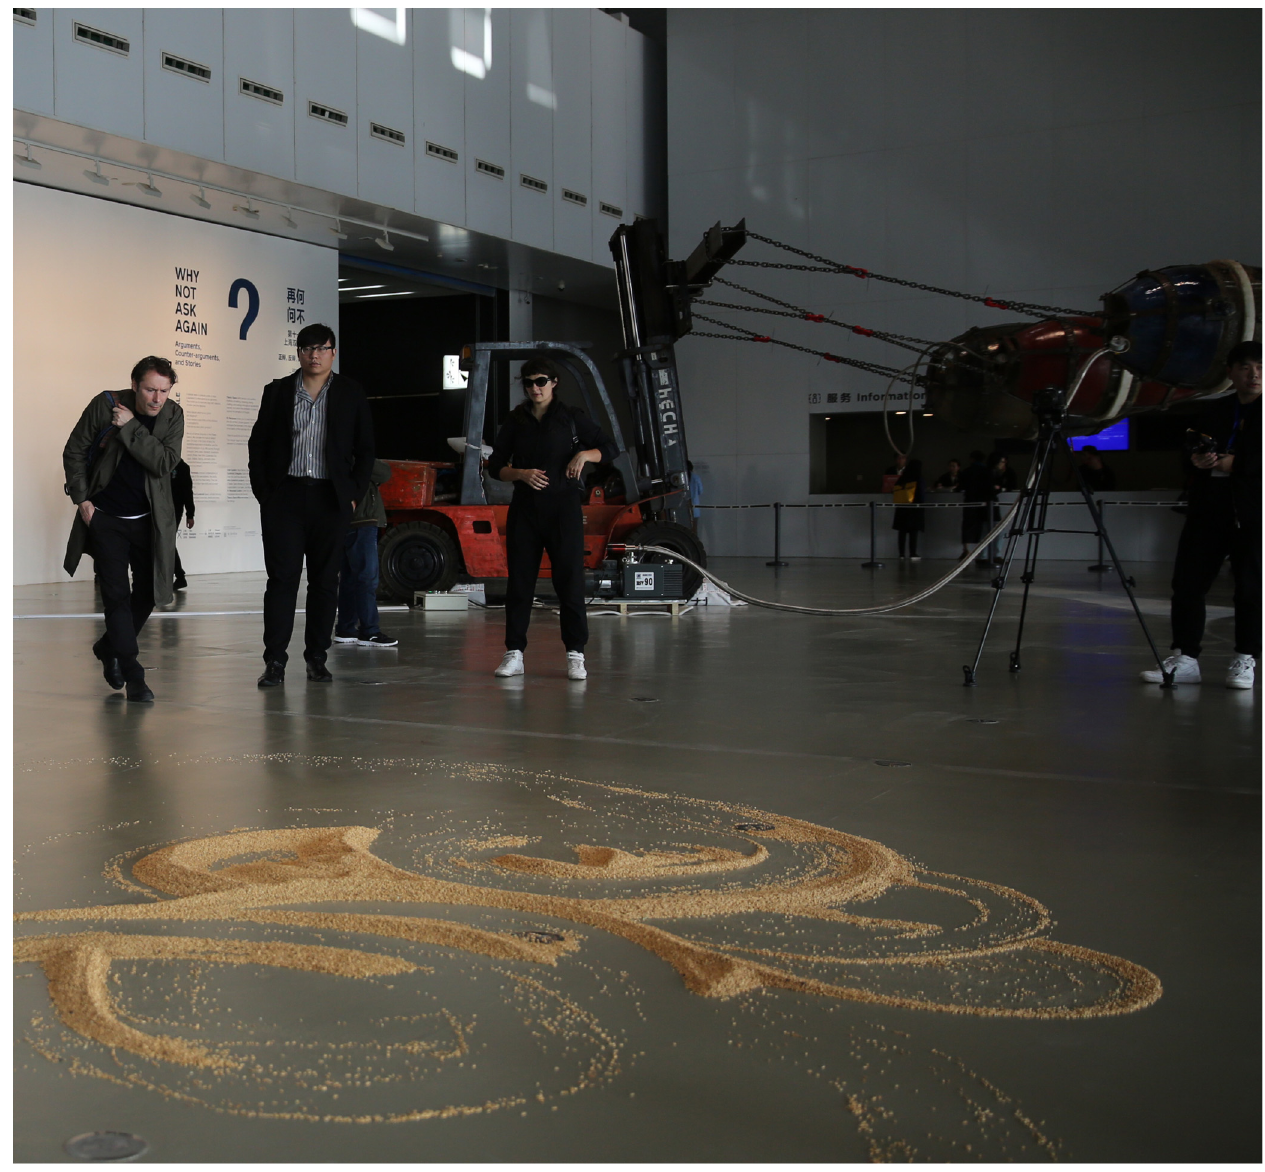
Figure 2. Why Not Ask Again? Shanghai Biennial, 2016. Image courtesy Power Station of Art.